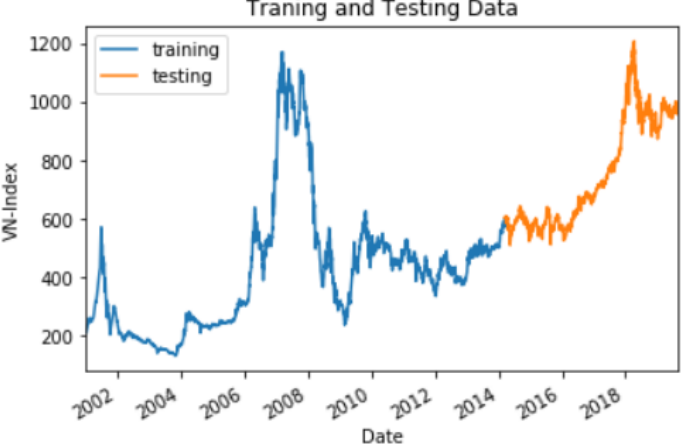
Fig. 11. Daily opening prices of VNINDEX from January 3, 2001 to August 30, 2019